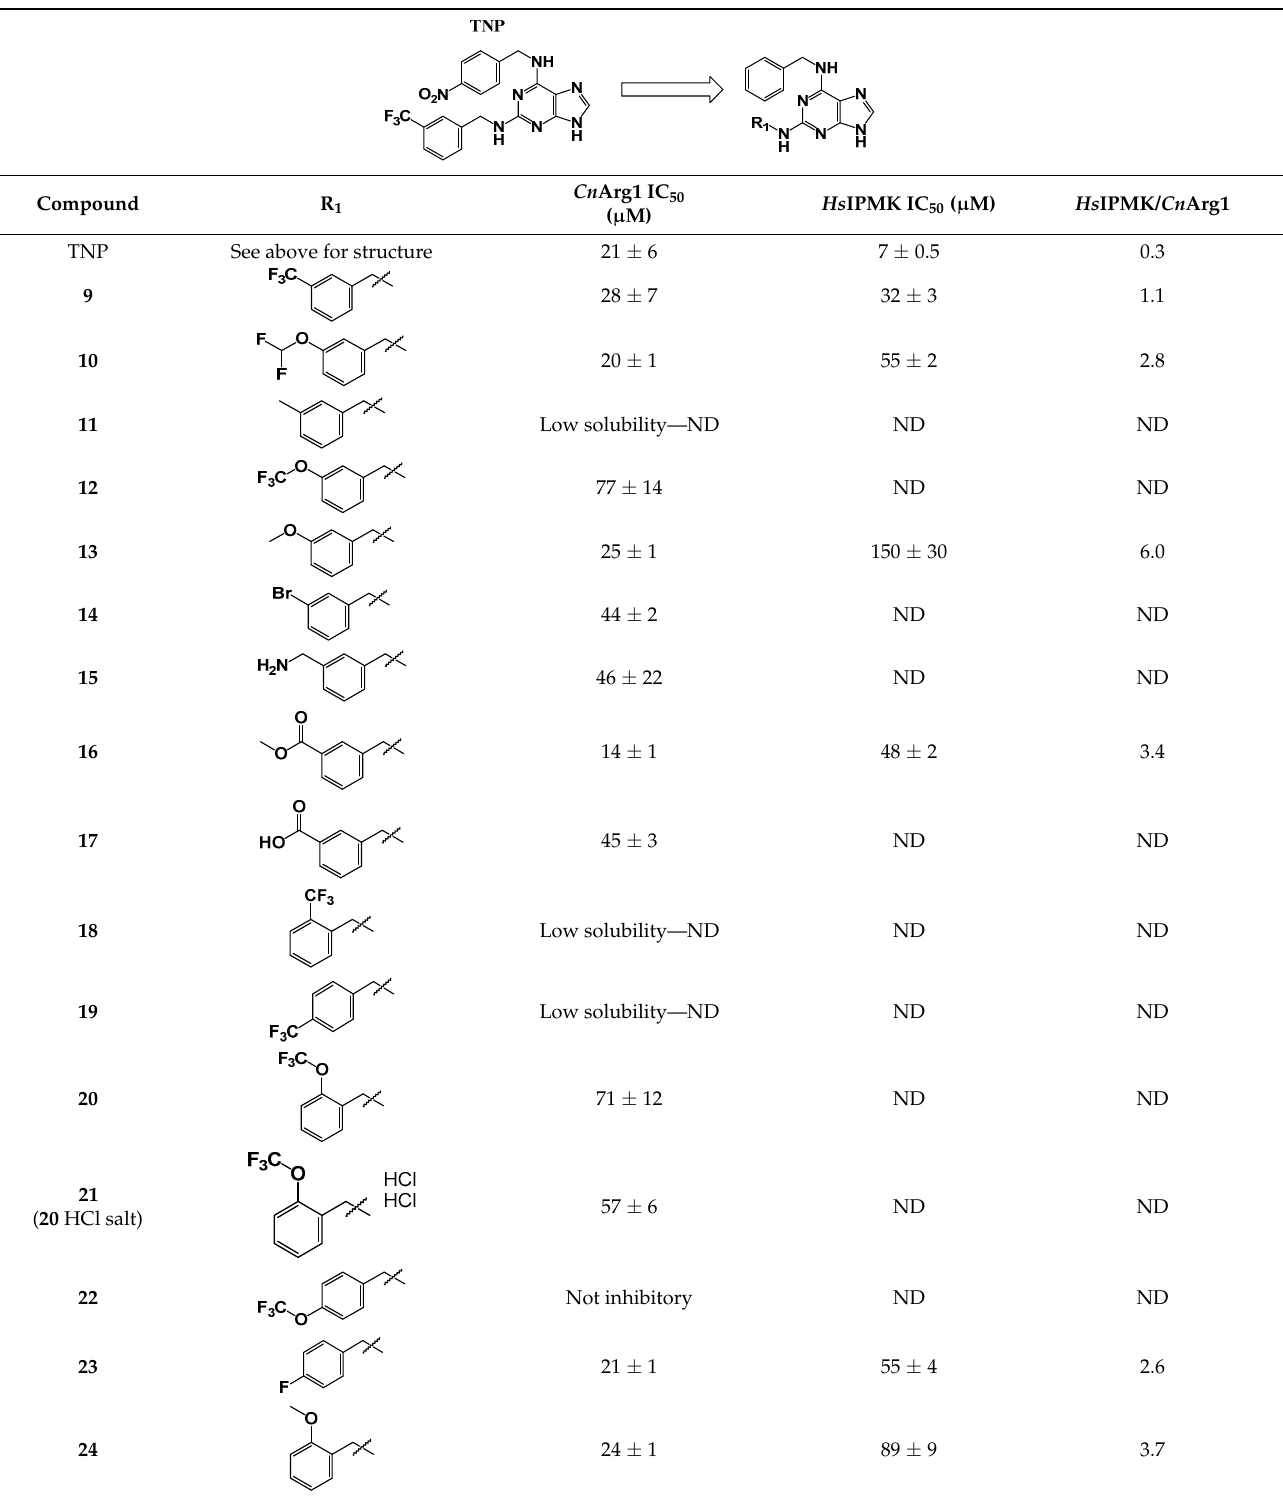
Table 3. Summary of inhibitory properties resulting from chemical exploration at the N 2 position of the TNP purine core following removal of the NO 2 group at the N 6 position (21 analogues). Only potent and soluble analogues with an IC 50 < 40 µM for Cn Arg1 were tested for inhibitory properties against Hs IPMK. ND = not determined.